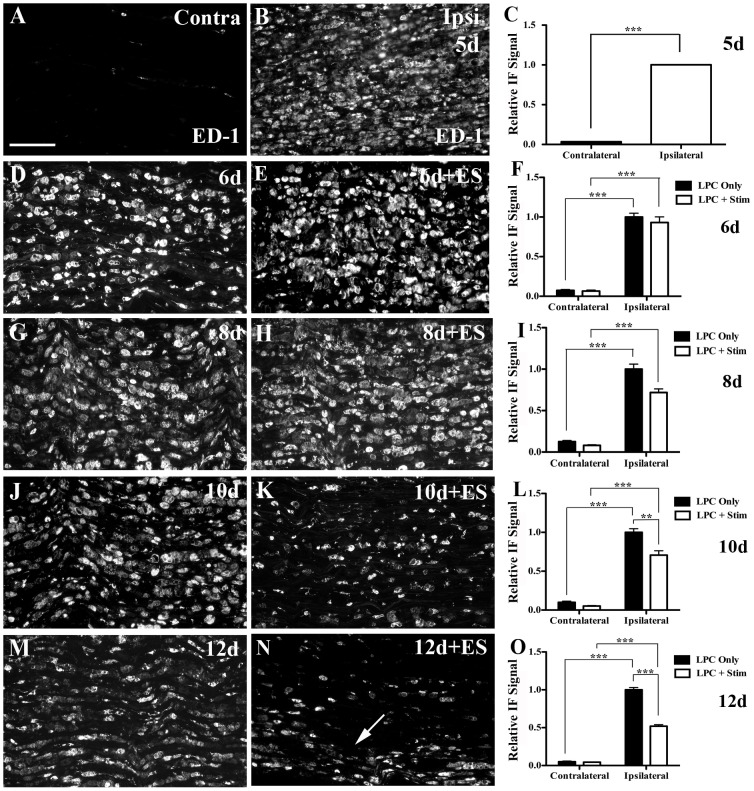
Decrease in number of activated macrophages in demyelinated nerves subjected to 1hr ES.Representative photomicrographs from FG-positive (i.e focally demyelinated) areas of longitudinal tibial nerve sections processed for ED-1 IF to detect activated macrophages. There was marked macrophage infiltration into the demyelination zone 5d post- lysophosphatidyl choline (LPC)/FG injection (B), while contralateral control nerves displayed only minimal ED-1 IF (A). Temporal analysis of LPC focal demyelination +/- ES delivered at 5 d post-LPC as indicated in days post-LPC: 6d (D), 6d+ES (E), 8d (G), 8d+ES (H), 10d (J), 10d+ES (K), 12d (M) or 12d+ES (N) post-LPC. Note: ES results in a significant decrease in the ED-1 IF 10d post-LPC (5d post-ES; K) and 12d post-LPC (7d post-ES; N) relative to LPC only in a pattern suggestive of movement toward lateral edges and egress (arrow). Summary bar graphs of relative changes in IF signal for ED-1 in the zone of demyelination (C, F, I, L, O). Note: for each time point examined, all values were normalized to the mean value of the Average Gray per micron2 readings for the nerves ipsilateral to LPC treatment for the LPC Only animal on that slide and for that time point. N = 4-6 animals analyzed per condition; regions quantified per condition: 35 ipsi and 36 contra (5d, LPC only); 89 ipsi and 69 contra (6d, LPC only); 52 ipsi and 53 contra (6d, LPC+Stim); 74 ipsi and 50 contra (8d, LPC only); 66 ipsi and 70 contra (8d, LPC+Stim); 79 ipsi and 64 contra (10d, LPC only); 87 ipsi and 61 contra (10d, LPC+Stim); 122 ipsi and 52 contra (12d, LPC only); 98 ipsi and 71 contra (12d, LPC+Stim). Asterisks indicate significant differences between experimental groups; *P<0.05, ***P<0.001. Scale bar = 100 µm.